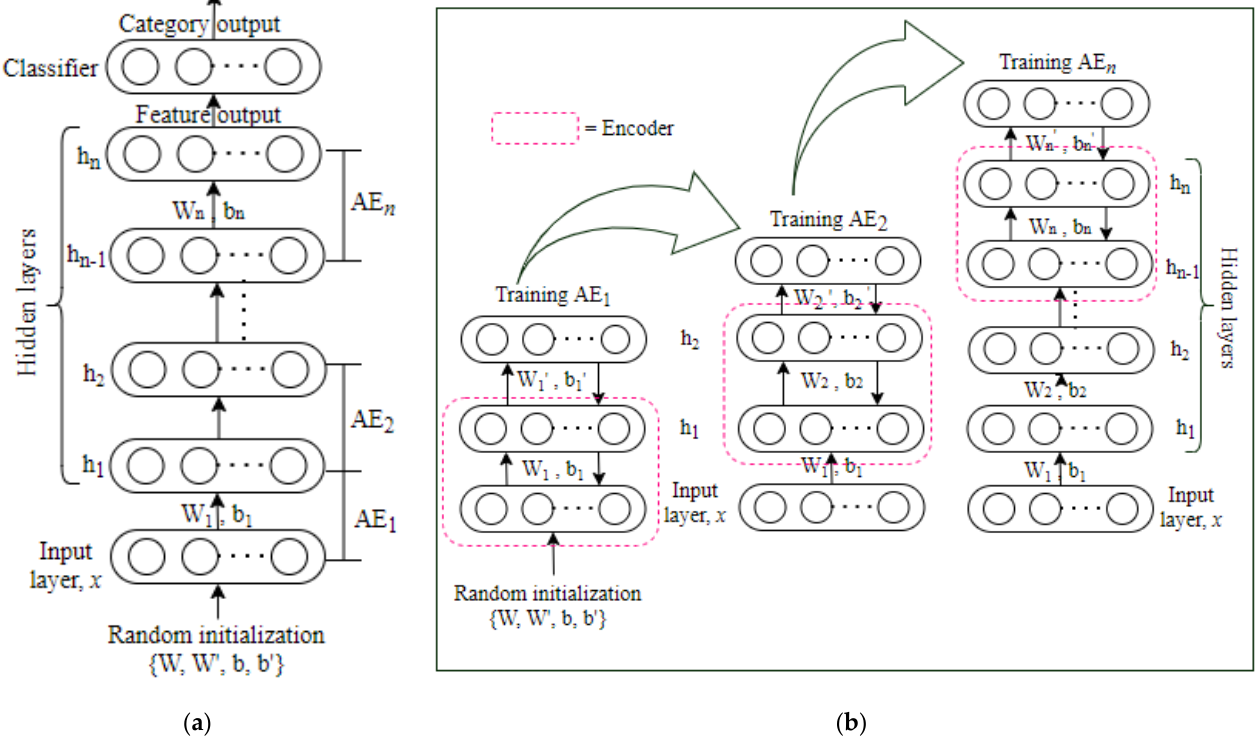
Figure 7. Structure and training process of stacked AE: ( a ) layout of the self-encoding network; ( b ) forward training of the self-encoding network.